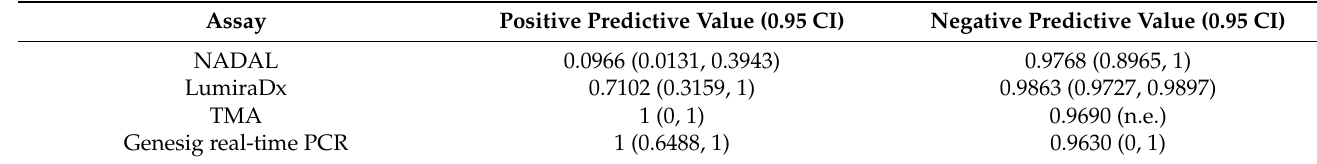
Table 7. Predictive values as calculated for the assessed assays in the low prevalence setting in which they were evaluated. Assay Positive Predictive Value (0.95 CI) Negative Predictive Value (0.95 CI)